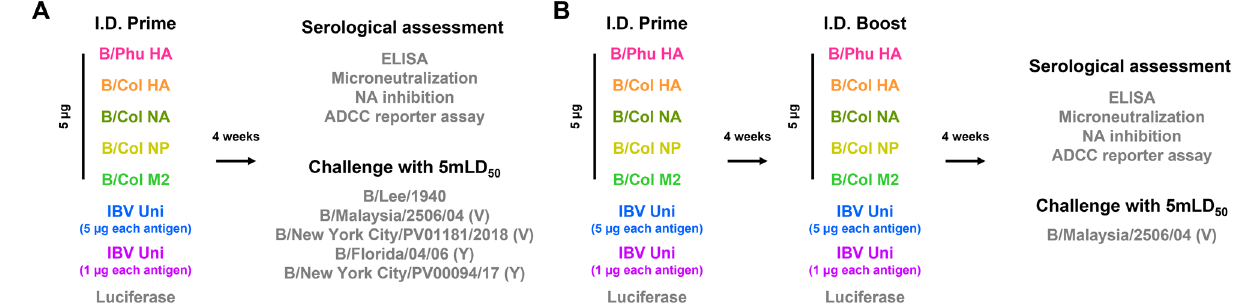
Fig. 2 | Experimental plan: vaccines, immunizations, serology and challenge studies. MicereceivedasingleI.D.immunizationwith5 µ gmonovalentmRNA-LNP vaccineor5 µ g(1 µ gfromeachcomponent)or25 µ g(5 µ gfromeachcomponent)of thepentavalentmRNA-LNPvaccine.Animalsinthenegativecontrolgroupreceived 5 µ g luciferase mRNA-LNP. Four weeks after vaccination, mice were intranasally (I.N.)infectedwithin fl uenzaviruscontaining1xor5xthemLD 50 .Additionally,mice